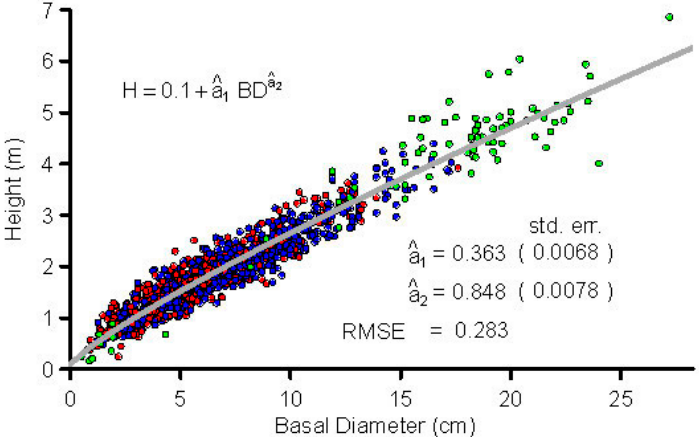
Figure 3. Height and basal diameter regression for combined non-linear fit of untreated (red), manual release (blue), and chemical release (green) trees.